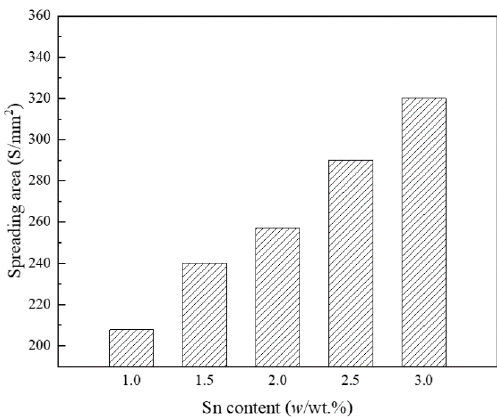
Figure 3. Variations in the wetting area of BAg20CuZnIn filler metals with increasing Sn content